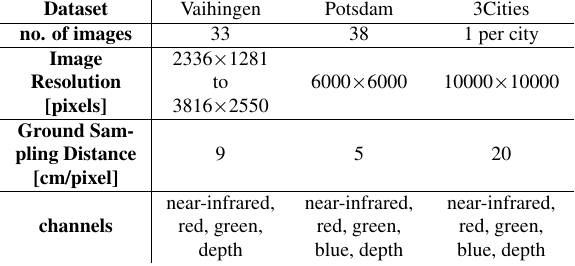
Table 1. Dataset details; 3Cities consists of the Hannover, Buxtehude and Nienburg